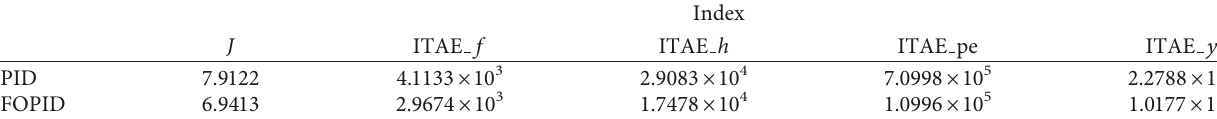
Table 10: Performance indicators with Δ f � − 0 . 5Hz.